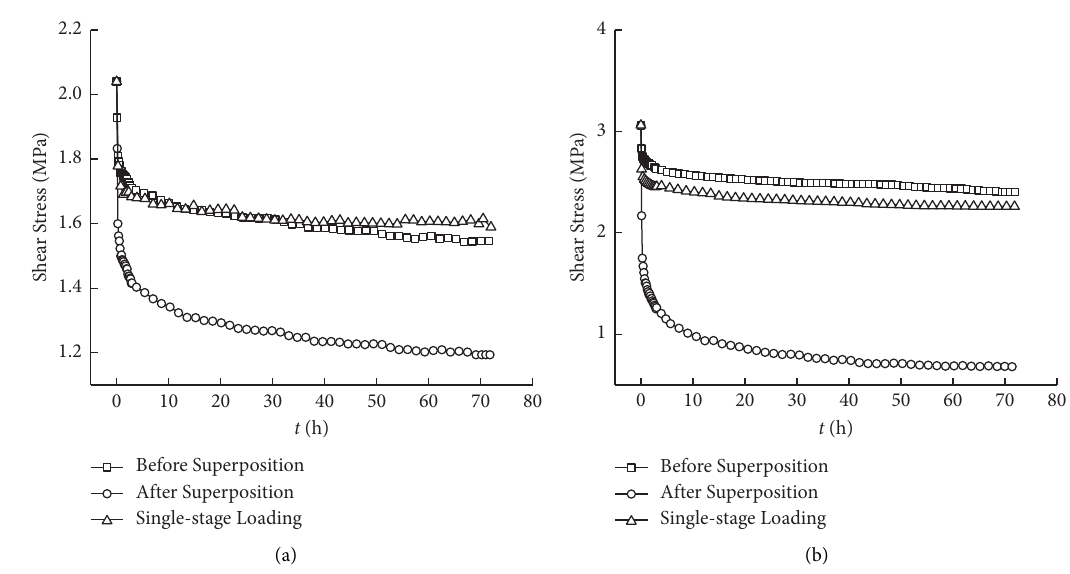
� 0 . 6, σ � 3.924MPa; (b) τ / τ 0 max